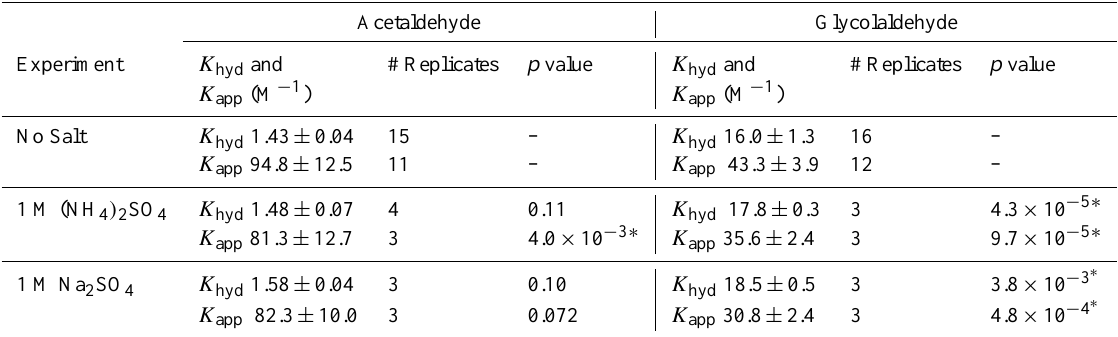
Table 4. Effects of inorganic salt addition on the hydration equilibrium constant (K hyd ) and the apparent α -HHP formation equilibrium constant ( K app ) .